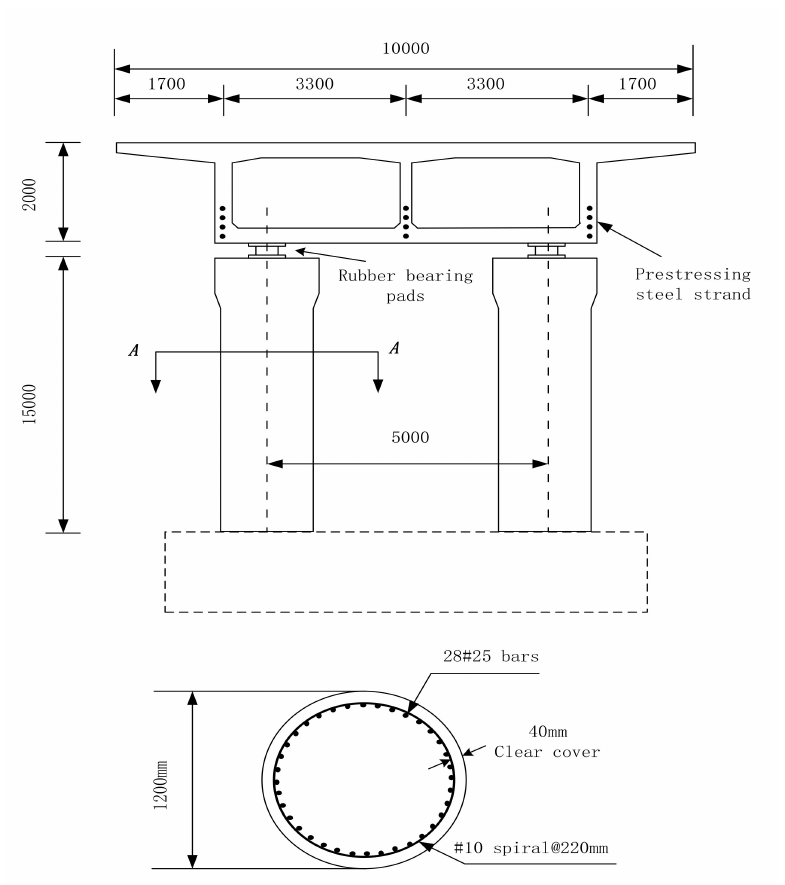
Figure 2. Dimensions and details of the bridge elevation and